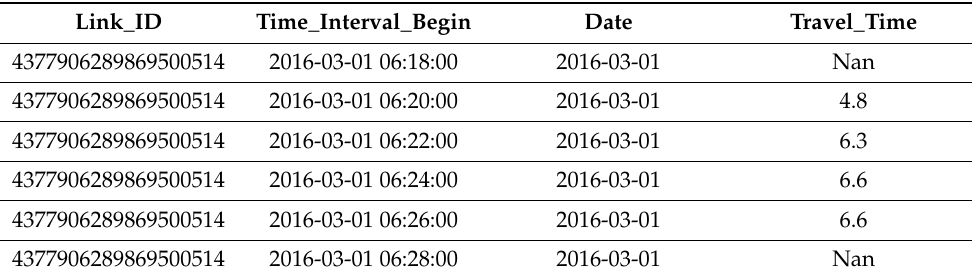
Table 1. Example for travel time of